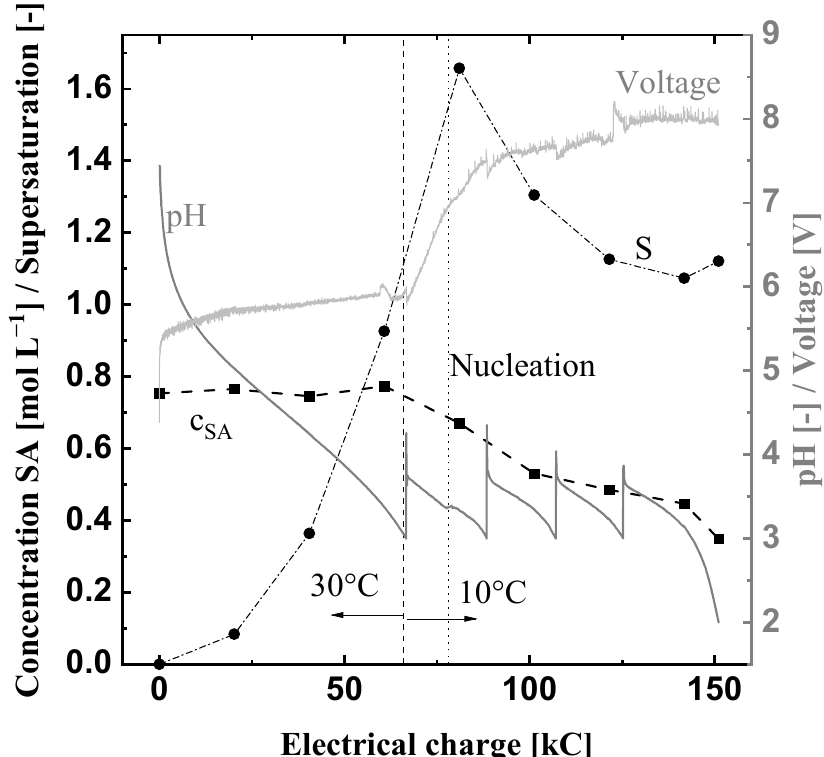
Figure 8. Electrochemical pH-shift crystallization in the prototype at 30 to 10°C, 0.075Acm − 2 and a volume flow rate ˙V of 0.52Lmin − 1 (Exp4). The black squares are the measured succinic acid concentration, the black cycles show the calculated supersaturation ratio S and the two gray lines display the course of the pH value and voltage of